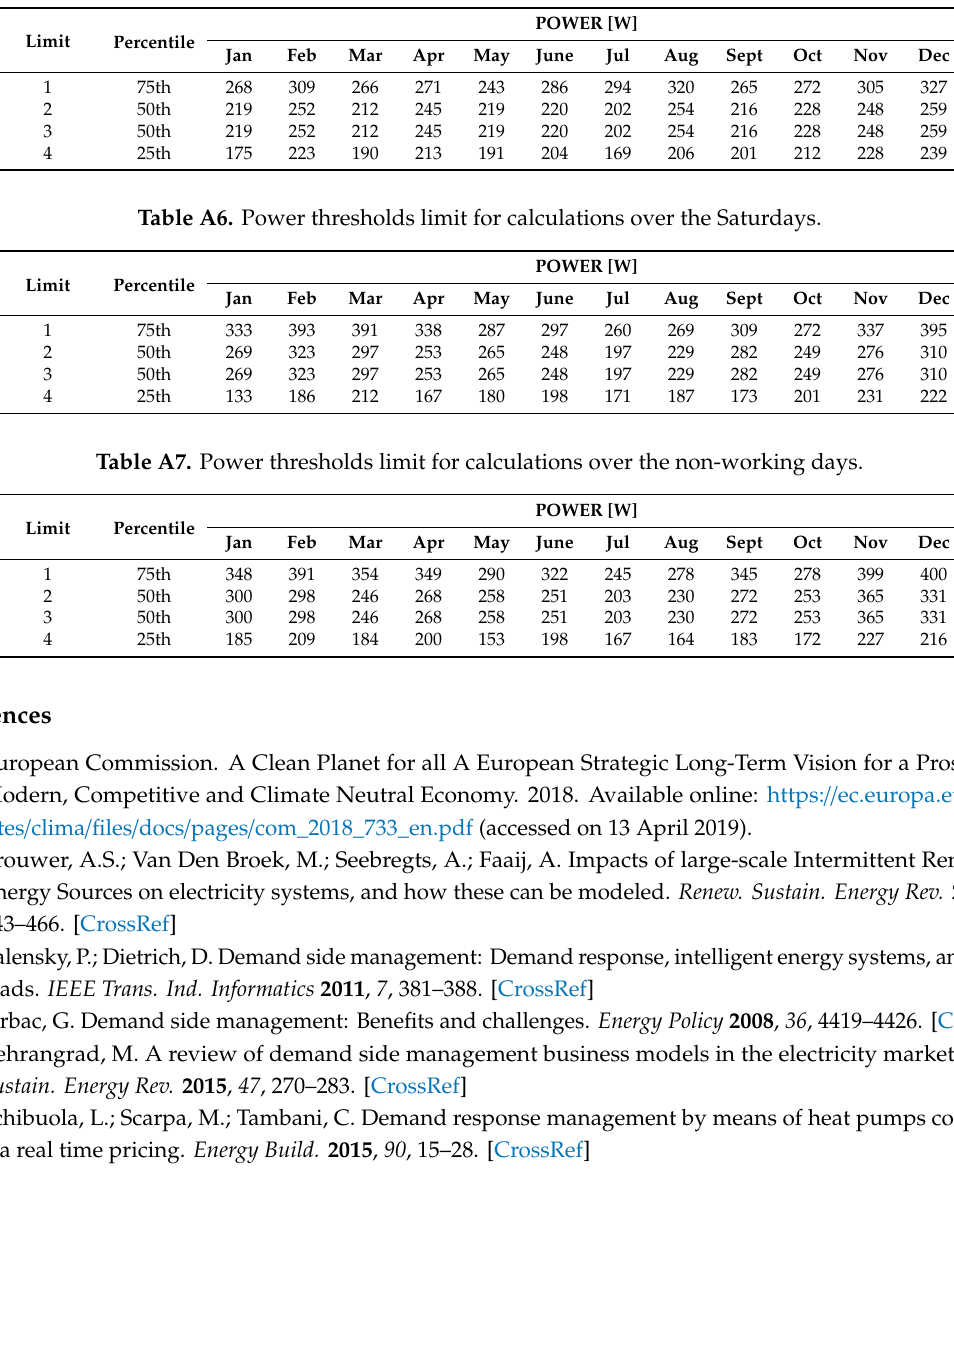
Table A5. Power thresholds limit for calculations over the weekdays.